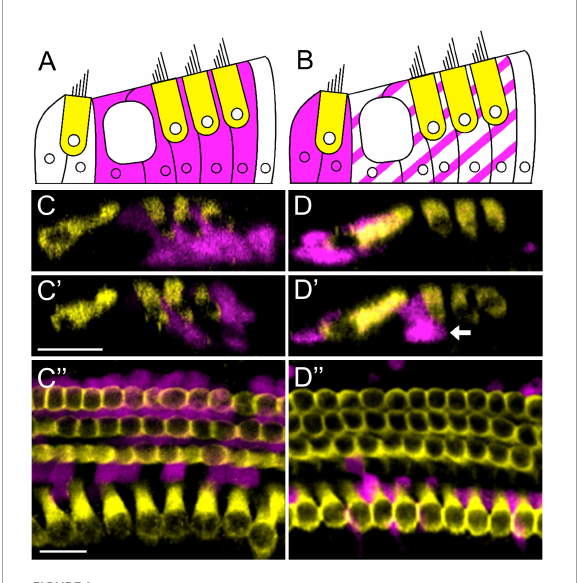
FIGURE1 Prox1 CreERT 2 and Plp-CreER T label different groups of cochlear supporting cell subtypes. (A,B) Illustration of a cochlear cross-section with one row of inner and three rows of outer hair cells (yellow) and tdTomato-positive (magenta) supporting cells labeled by Prox1 CreERT 2 (A) or Plp-CreER T (B) . (C–D”) Representative images from the apical turn of Prox1 CreERT 2 :Rosa26 tdTomato (C–C”) and Plp-CreER T :Rosa26 tdTomato (D–D”) mice at P7. All mice were injected with tamoxifen at P0 to induce tdTomato expression in various groups of supporting cells. Samples were immunostained with anti-Myo7a (yellow) to label all hair cells, and tdTomato was detected using endogenous fluorescence (magenta). Prox1 CreERT 2 labels primarily pillar and Deiters’ cells (A,C–C”) , whereas Plp-CreER T labels primarily inner phalangeal and border cells (solid magenta in B ), along with a small number of pillar and Deiters’ cells (striped magenta in B ) (B,D–D”) . White arrow (D’) indicates an outer pillar cell labeled by Plp-CreER T